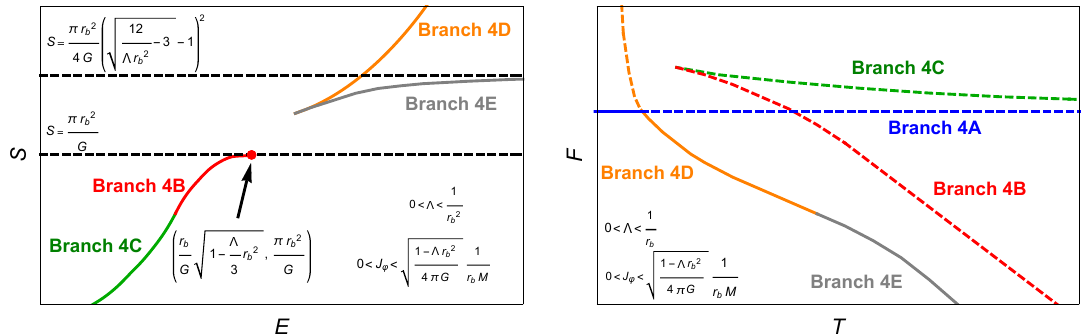
Figure 20 . Qualitative behaviors of entropies (left panel) and free energies (right panel) when q 1 − Λ r 2 0 < Λ < 1 and 0 < J . Branch 4A is of the Euclidean soliton, branches 4B 1 b ϕ < 4 πG r b M r 2 b and 4C are of the Euclidean BH, and branches 4D and 4E are of the BG instanton. ( Left ) The entropy of branch 4D, which is the dominant saddle at high energy, has no bound and increases indefinitely. Unlike that branch, the entropy of 4E has the bound S = πr 2 b ( Right ) The thermodynamically stable branches are 4A, 4B, and 4E. Although 4A dominates at low temperature, it suffers from quantum tunneling to 4D. Therefore, the system is thermodynamically unstable at low temperature. On the other hand, 4E does not suffer from quantum tunneling